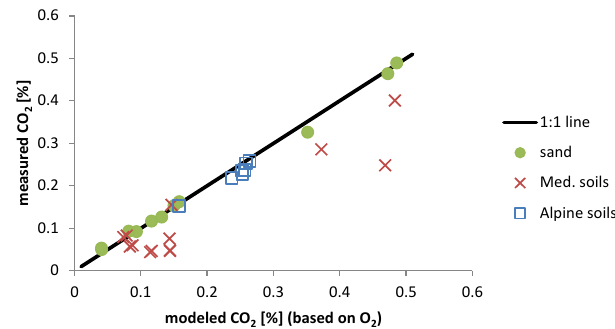
Figure 3. Temporal changes in − (cid:49) O 2 (open blue squares, O 2 de- crease from ambient) and 0.76 (cid:49) CO 2 (red diamonds, CO 2 increase above ambient corrected for lower gas diffusivity compared to O 2 ) at the soil of site 3 (pine stand; 40cm depth) from May 2012 to August 2013. Most error bars are smaller than the markers.